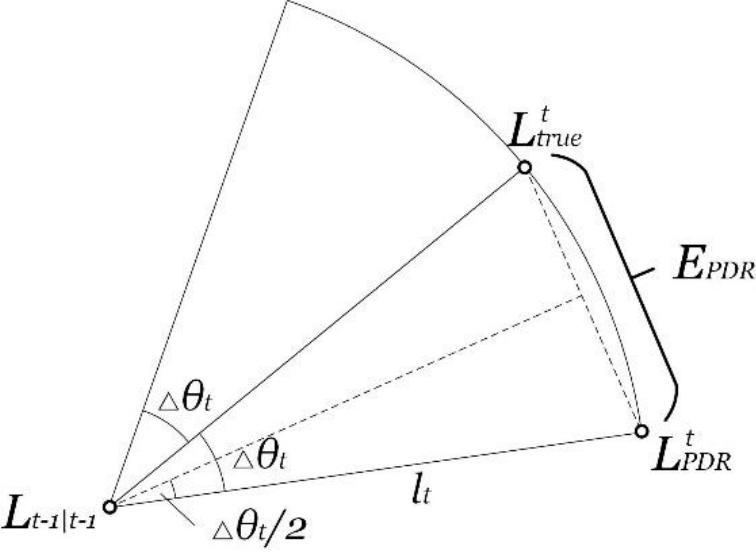
Figure 5. PDR positioning error estimation.